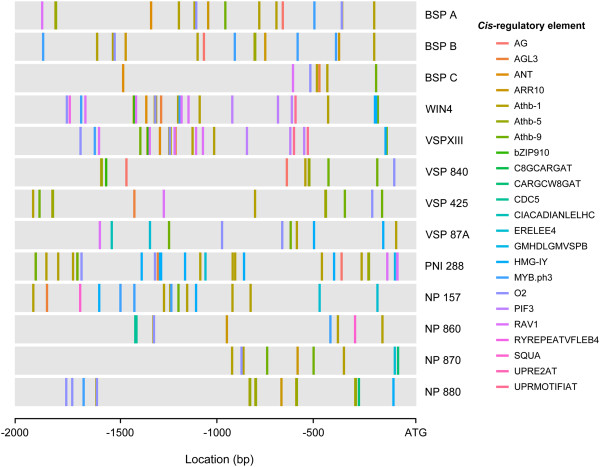
Cis-regulatory element distribution in the promoter regions of NP-like genes in Populus trichocarpa. CREs identified by two methods of motif prediction are represented as colored bars and correspond to the CRE name.